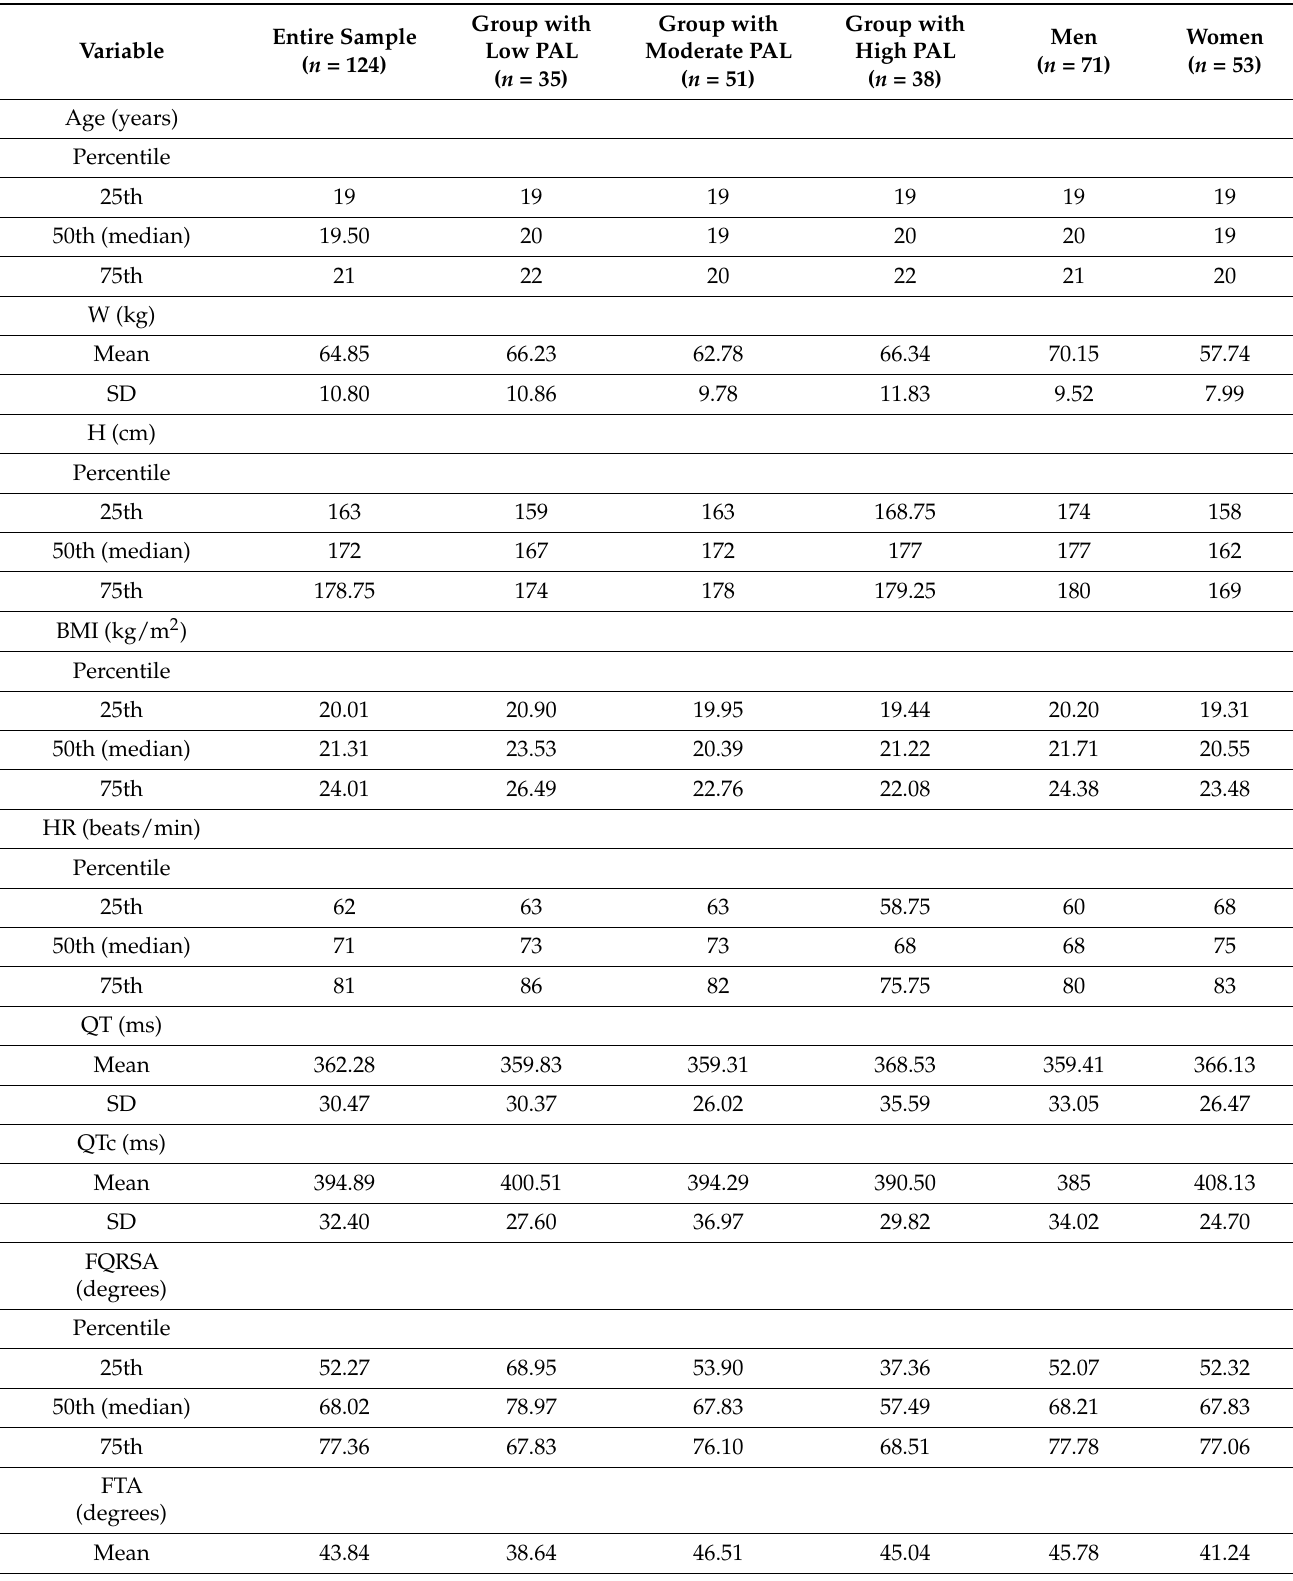
Table 1. Baseline descriptive statistical indicators for investigated